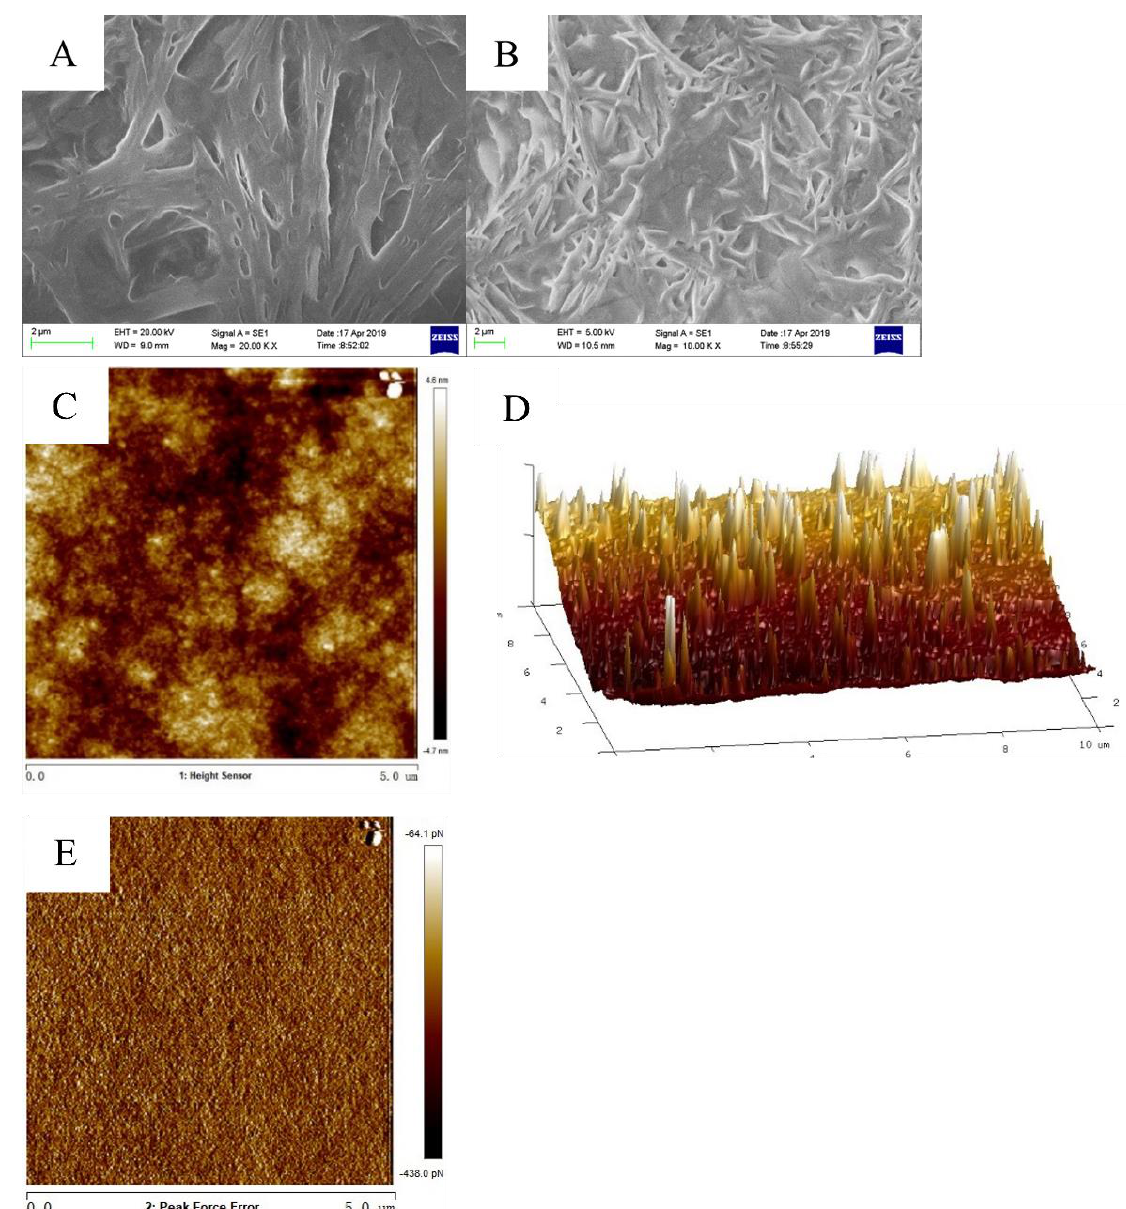
Figure 4. The imaging of scanning electron microscopy of HGP-3 with ( A ) 2000× Mag, ( B ) 1000×. The imaging of atomic force microscopy (AFM) of HGP-3 with ( C ) 2D − images, ( D ) 3D − image, and ( E ) Van Der Waals force image.